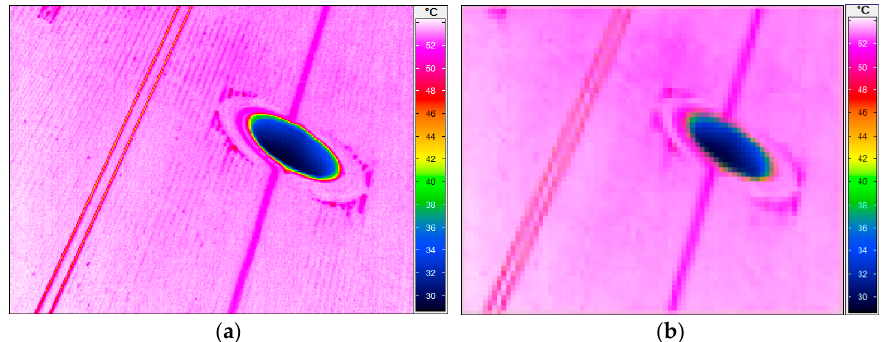
Figure 6. ( a ) Boiler screen thermogram using a telephoto lens 6 × 8, and ( b ) using a standard lens 50 × 68.